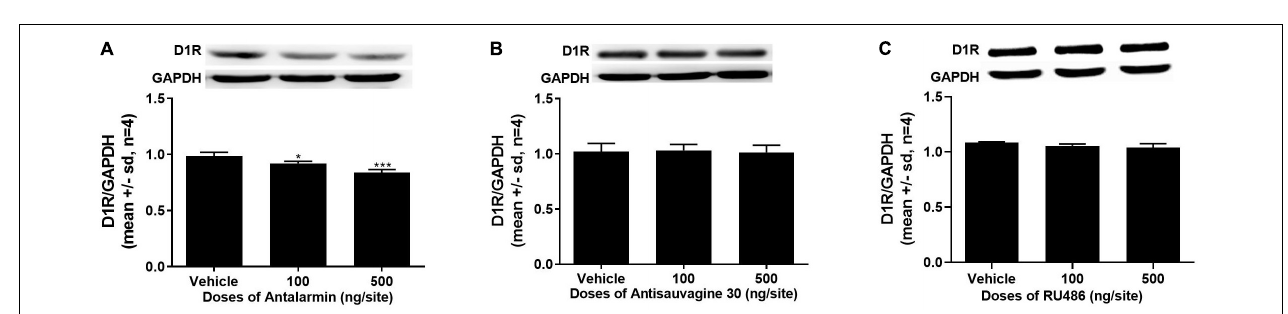
FIGURE 2 | (A) Intra-lateral ventricle injection of corticotropin-releasing factor (CRF) receptor-1 (CRF1R) antagonist antalarmin attenuated active nose-poke responses and propofol infusions in a dose-dependent manner (active nose-poke response p < 0.001, infusion p < 0.001, n = 8) in the rats who received tail clip stimulation before daily training and the testing session, while the numbers of inactive nose-poke responses did not show a significance compared with the vehicle group ( p = 0.32). (B) Intra-lateral ventricle pretreatment of the CRF receptor-2 (CRF2R) antagonist antisauvagine 30 did not alter the active nose-poke responses ( p = 0.94), propofol infusions ( p = 0.39), or inactive nose-poke response ( p = 0.95). (C) The pretreatment with the glucocorticoid receptor (GR) antagonist RU486 at the lateral ventricle was unlikely to affect the active nose-poke responses ( p = 0.95), propofol infusions ( p = 0.26), or inactive nose-poke responses ( p = 0.59). The normally distributed data were analyzed by one-way ANOVA with Dunnett’s post hoc test for multiple comparisons, otherwise were analyzed with a Kruskal–Wallis test. SD, standard deviation.* p < 0.05, *** p < 0.001.